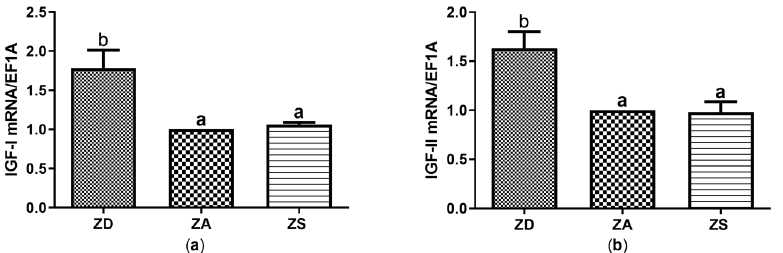
Figure 4. SF cells were cultured in CHELEX-treated medium, zinc adequate (ZA) medium or medium supplemented with zinc (50 µ M) for 7 days. Afterwards mRNA was isolated, used for measuring expression of SOD1 ( a ) and Catalase ( b ) mRNA expression and normalized to EF1A mRNA. Mean values + S.E.M. of n = 7 independent experiments are shown. Significantly different data sets as determined by one-way Anova and Tukey’s post hoc test do not share the same letters ( p < 0.05).